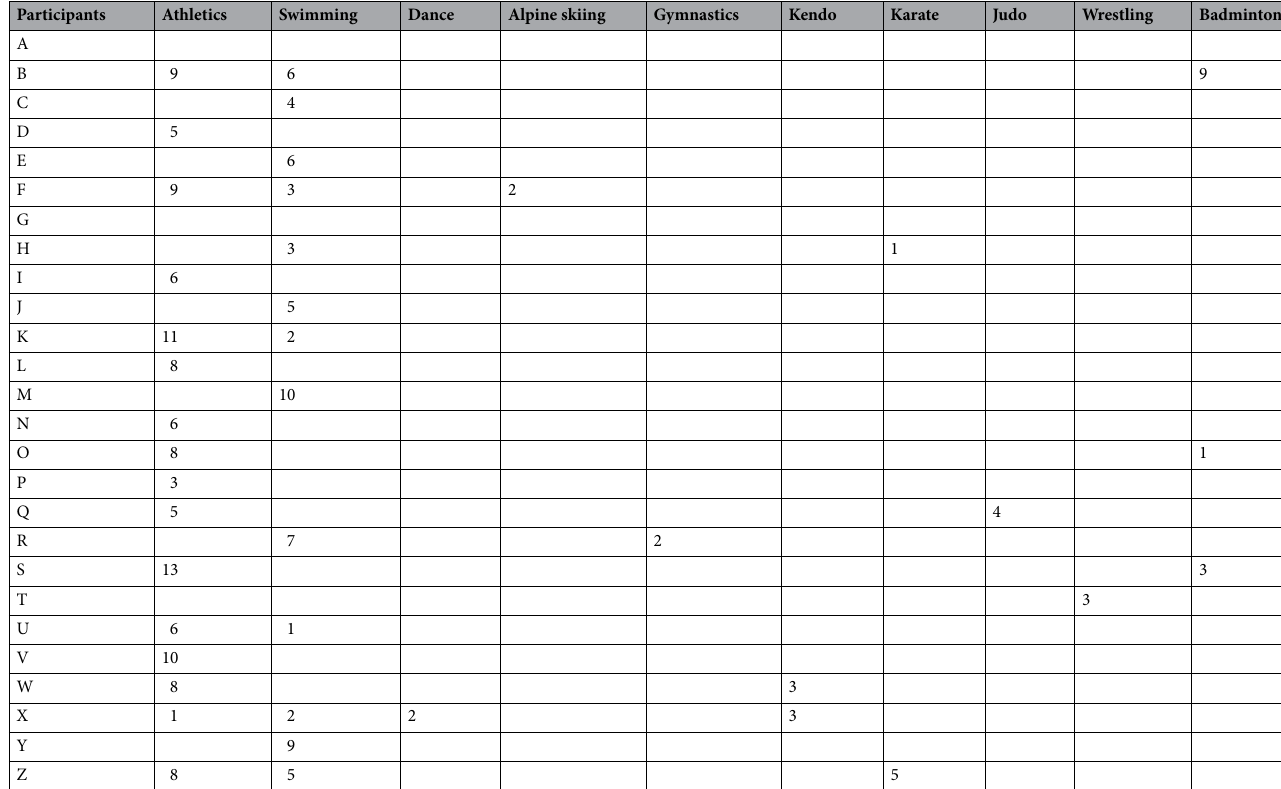
Table 1. Experiences (sports event and years) in non-ball sports. Each number shows the total years of experience in each sport. Athletics include short-distance running, long-distance running, throwing, and jumping. Kendo is traditional Japanese